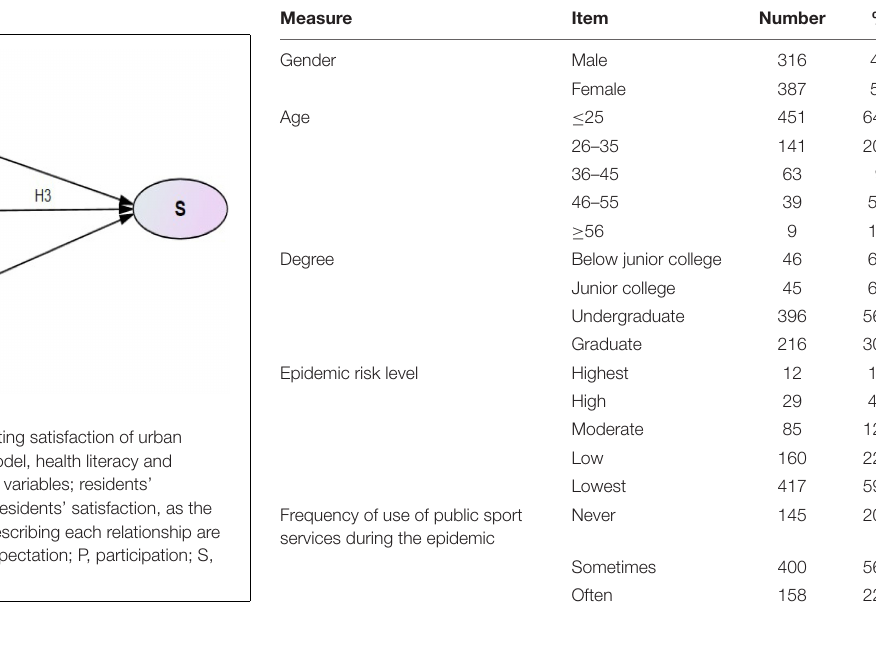
TABLE 1 | Demographic characteristics (N =